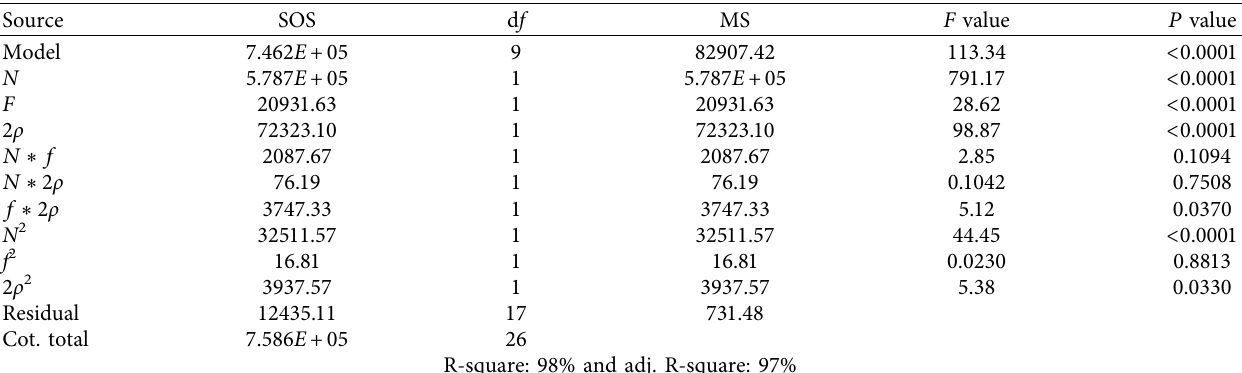
Table 4: ANOVA for cutting